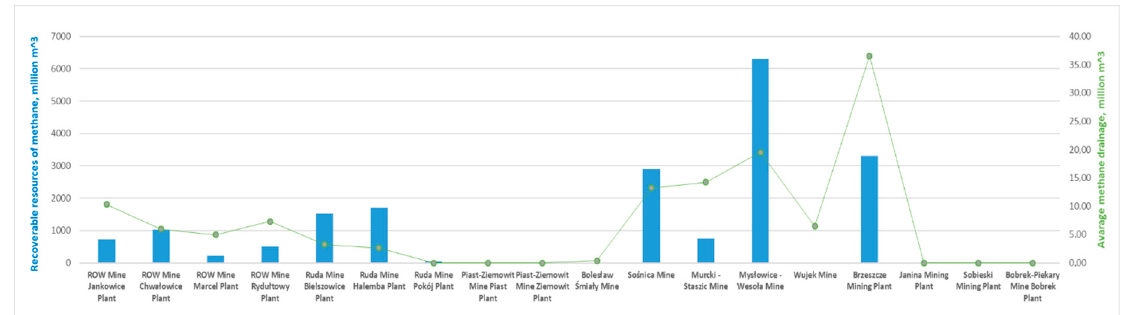
Figure 5. Summary of recoverable methane in mines/mining plants in terms of the average amount of methane included in methane drainage, from the authors’ study according to